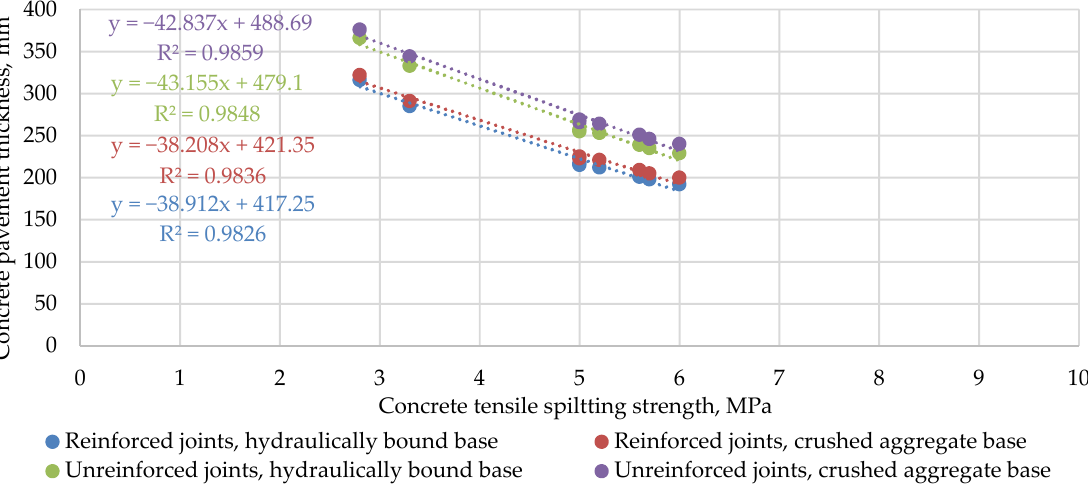
Figure 4. Calculated PCP thicknesses on crushed aggregates base.